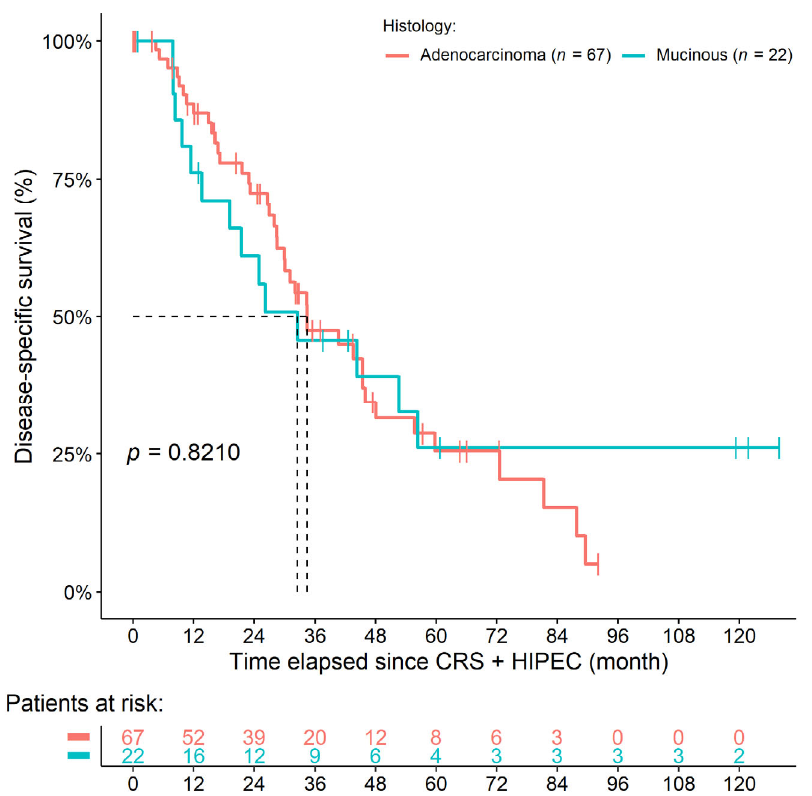
Figure 2. Survival curves of colorectal cancer patients with metachronous peritoneal metastasis. No difference could be found between those patients with mucinous or non-mucinous adenocarcinoma. Table 4. Results of uni ‐ and multivariate survival models of study participants with metachronous peritoneal metastases.